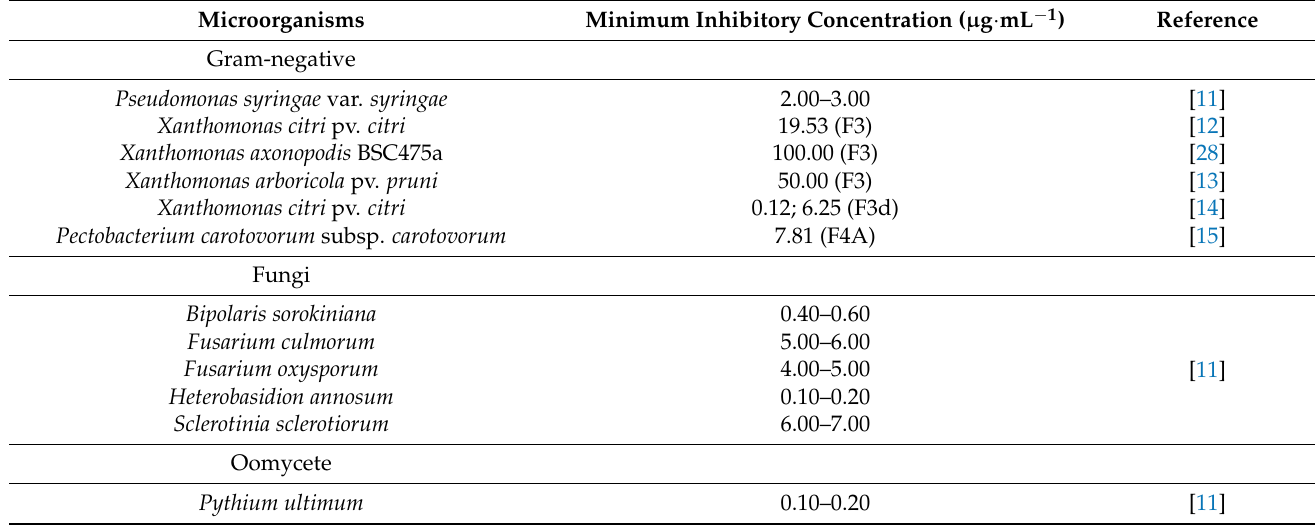
Table 3. Susceptibility of phytopathogens to Fluopsin C and to semi-purified fractions (F3, F3d, and